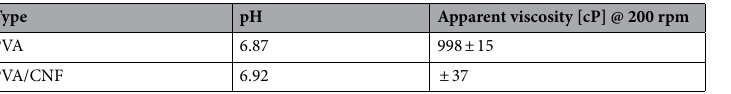
Table 3. Coating properties. Note: The concentration of PVA was 10%, and the CNF dosage was 3.0% (relative to the mass of PVA).